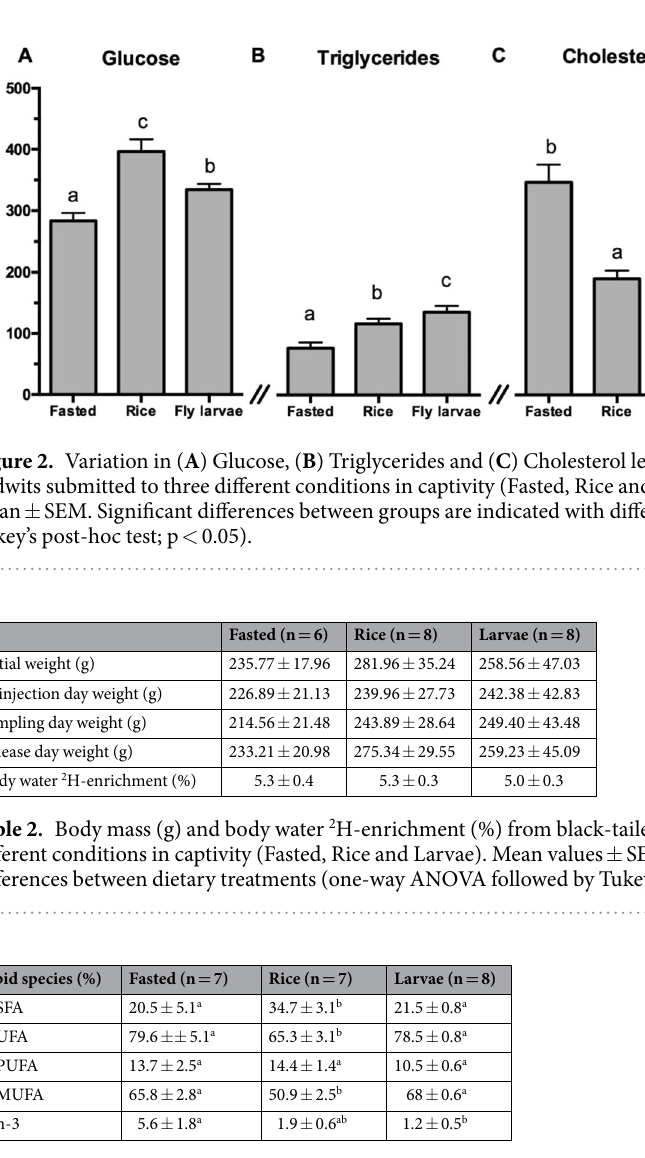
Table 3. Lipid species and chemical structure of esterified fatty acids as determined from 1 H NMR spectra of subcutaneous fat triglycerides from black-tailed godwits submitted to three different conditions in captivity (Fasted, Rice and Larvae). Mean values ± SEM are presented. Significant differences between dietary treatments are indicated by different letters (one-way ANOVA, p < 0.05; followed by Tukey’s